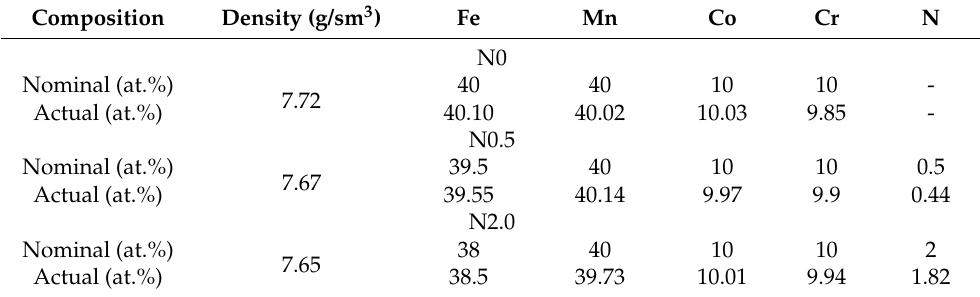
Table 1. Measured chemical composition of the program alloys. Composition Density (g/sm 3 ) Fe Mn Co Cr N N0 Nominal (at.%) 40 40 10 10 - 7.72 Actual (at.%) 40.10 40.02 - N0.5 Nominal (at.%) Actual (at.%) N2.0 Nominal (at.%) Actual